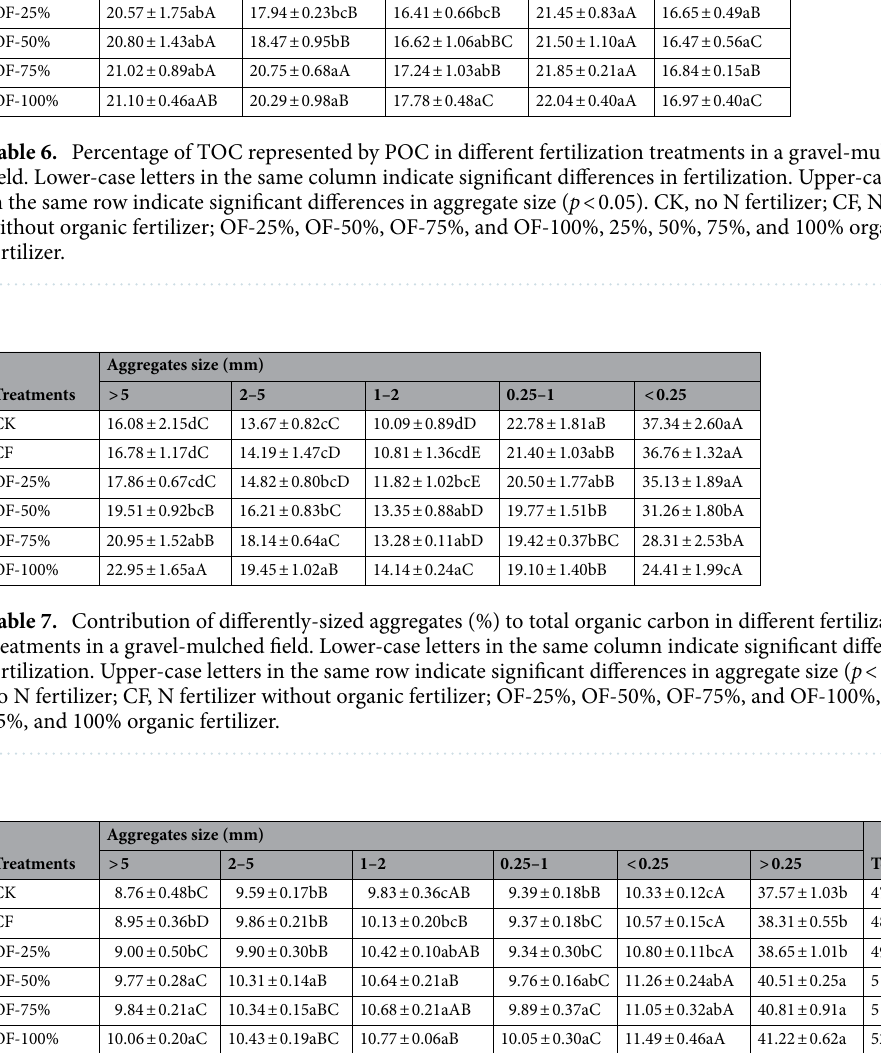
Table 8. Total organic carbon storage (Mg per ha) of aggregate fractions in different fertilization treatments in a gravel-mulched field. Lower-case letters in the same column indicate significant differences in fertilization. Upper-case letters in the same row indicate significant differences in aggregate size ( p < 0.05). CK, no N fertilizer; CF, N fertilizer without organic fertilizer; OF-25%, OF-50%, OF-75%, and OF-100%, 25%, 50%, 75%, and 100% organic